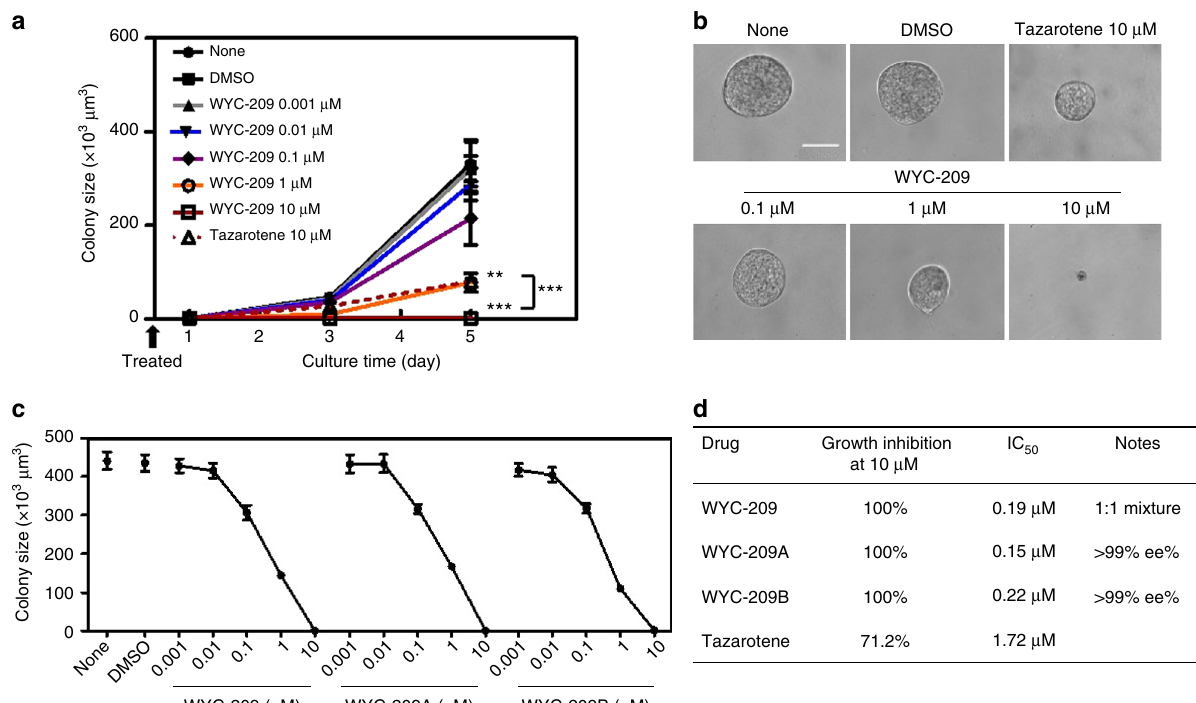
Fig. 2 Colony growth of TRCs was abrogated by WYC-209. a None: non-treated B16-F1 cells cultured in 90-Pa fi brin gels. DMSO: Control B16-F1 cells cultured in 90-Pa fi brin gels and treated with 0.1% DMSO (dimethyl sulfoxide, solvent for WYC-209) on day 0. WYC-209 0.001 μ M, WYC-209 0.01 μ M, WYC-209 0.1 μ M, WYC-209 1 μ M and WYC-209 10 μ M: Control B16-F1 cells were cultured in 90-Pa fi brin gels treated with WYC-209 on day 0 with various concentrations. Tazarotene 10 μ M: Control B16-F1 cells were cultured in 90-Pa fi brin gels treated with 10 μ M Tazarotene on day 0 as positive control. P < 0.002 between DMSO and WYC-209 1 µ M; P < 0.0004 between DMSO and WYC-209 10 µ M on day 5; P < 1.1e − 7 between WYC-209 10 µ M and Tazarotene 10 μ M on day 5. Mean± s.e.m.; ** P < 0.01; *** P < 0.001; at least three independent experiments. b Representative images of colonies on day 5 in a ; Scale bar, 50 μ m. c Dose-effect curves of WYC-209, WYC-209A, and WYC-209B. Quanti fi ed colony sizes on day 5 after B16-F1 cells were cultured in 90-Pa fi brin gels and treated with different conditions. None: medium without drugs. DMSO: medium with 0.1% DMSO. Mean± s.e.m.; three